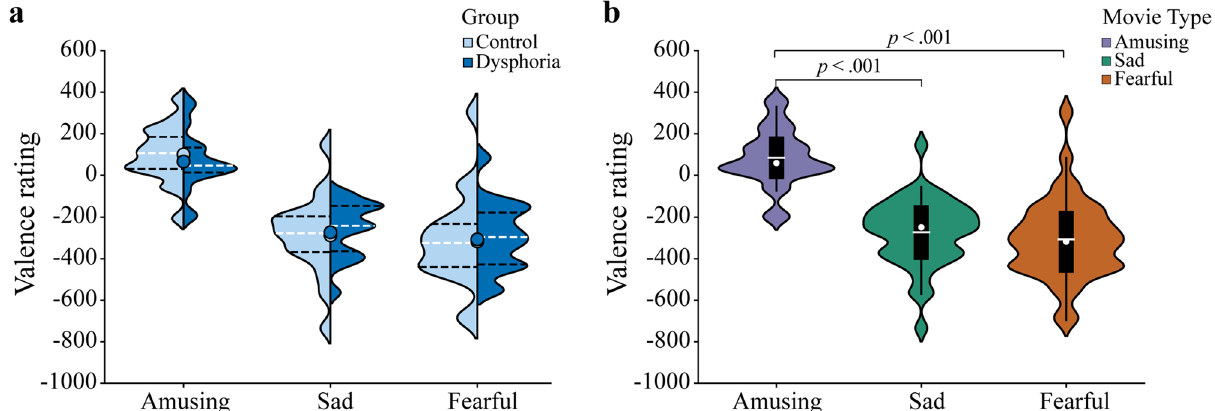
Figure 3. Violin plots for the valence ratings averaged over the timepoints separately for each movie type. For both ( a,b) , violin plot outlines illustrate the distribution of valence rating estimates using kernel probability density with the bandwidth of 0.2. Wider area of the violin plot represents a higher probability of the values that the valence ratings take on, and the thinner area corresponds to a lower probability. ( a ) The mean valence rating values to each movie type in each group (no significant group differences). Each side of the violin corresponds to a different group. Dots denote means of the valence rating. Horizontal white dotted lines show median of the valence rating and horizontal black dot lines represent the interquartile range (IQR) of the valence rating. ( b ) The mean valence rating values to each movie type averaged over the control and dysphoric groups. White dots on the violin plots show the median of the valence rating and horizontal white lines represent the means of the valence rating. The black bars in the centre of violins denote the IQR of the valence rating. The black lines stretched from the bars show the lower and upper adjacent values (1.5 times the IQR) of the valence rating, respectively.